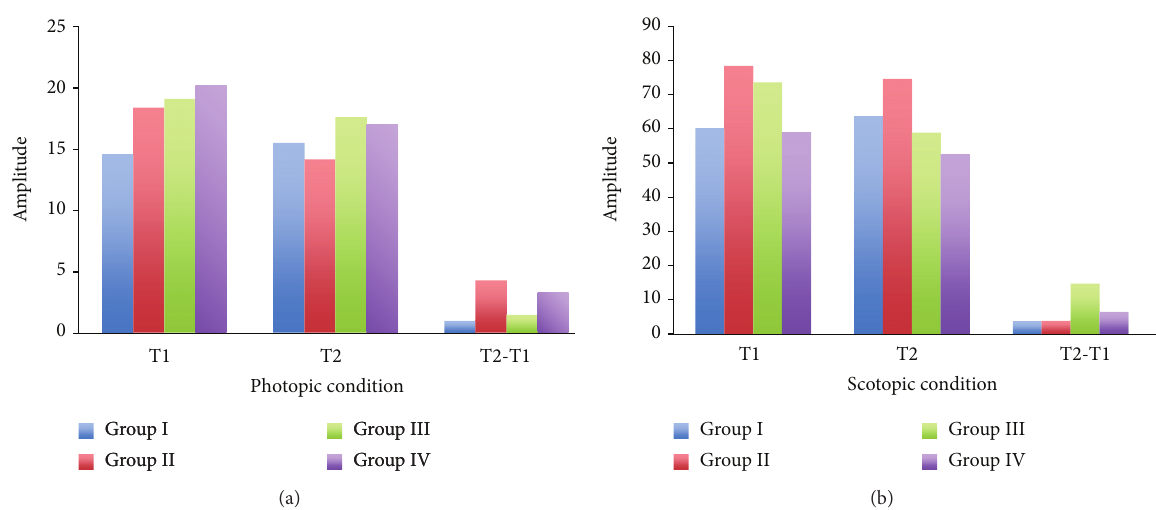
Figure 2: The electroretinogram (ERG) was performed on the control (Group I), diabetes (Group II), and diabetes + taurine (Group III, Group IV) groups on week 5 (T1) and week 15 (T2). The averaged a-wave amplitude under the photopic (a) and scotopic (b) conditions was recorded and analyzed.